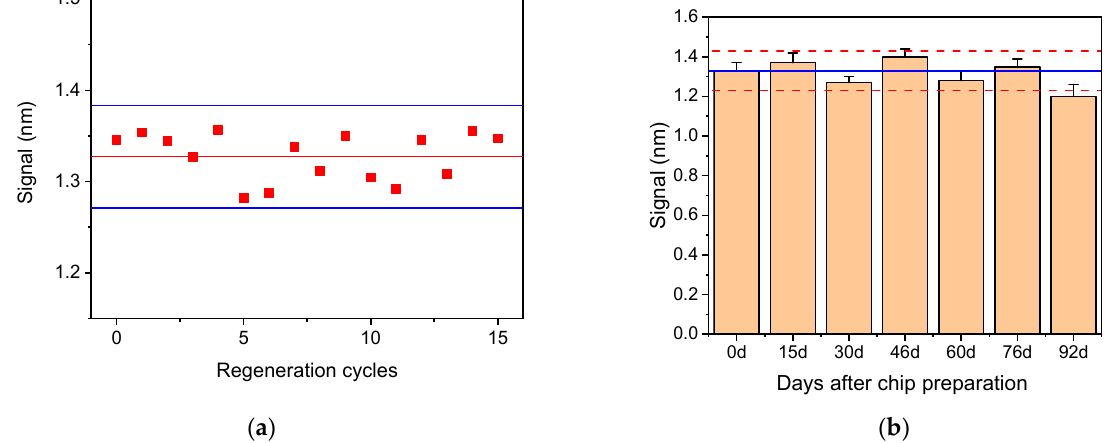
Figure 11. ( a ) Zero calibrator signal obtained from a single chip after 15 repetitive regeneration cycles. Horizontal solid red line corresponds to the mean value of 15 measurements, while the blue lines correspond to mean value ± 2SD. ( b ) Zero calibrator signals obtained from 21 chips modified with Salmonella LPS and tested over a period of 3 months. Each bar is the mean value of three chips ±SD. Blue line corresponds to mean value of the first six runs (up to day 76), and dashed red lines correspond to mean value ± 2SD.